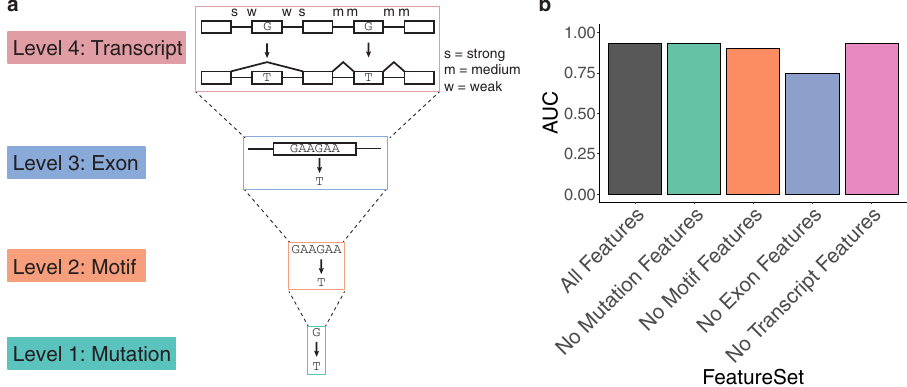
Fig. 2 Hierarchy of features for variant prediction. a Features are categorized into one of four groups: mutation, motif, exon, and transcript. Examples of mutation features include the speci fi c base pair change (G → T mutations disrupt splicing above all others), and whether or not the wild-type or mutant allele is predicted to be hybridized. Examples of motif features include change in Maxent score, and the changes in cis-element scores for hexamers affected by the mutation. Examples of exonic features include splice site usage and average EI score for all hexamers in the exon. Examples of transcript features include the number of exons in the transcript, and gene length. b Bar plot of the area under the curve (AUC) for different iterations of the GBM classi fi er with certain feature groups excluded.